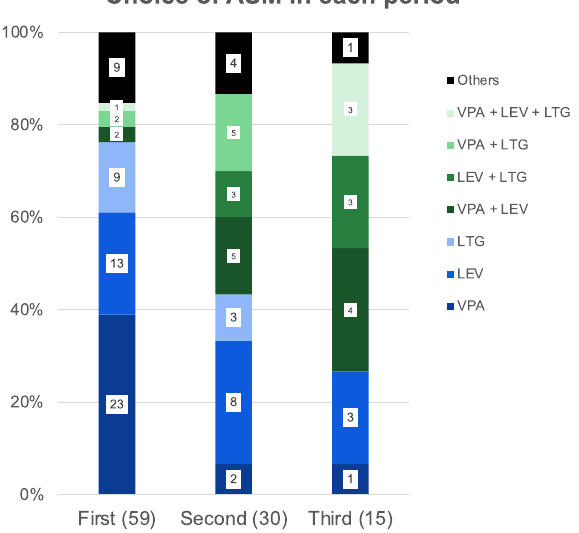
Figure 1. ASM choice in each period. Proportion of ASM used based on chronological periods. The absolute numbers of periods are presented in parentheses. Monotherapy regimens are represented in blue and combination therapy regimens in green. Other medications include mono or combination therapy with topiramate, phenobarbital, lacosamide, ethossuximide, and carbamazepine. The fourth period is not represented in this